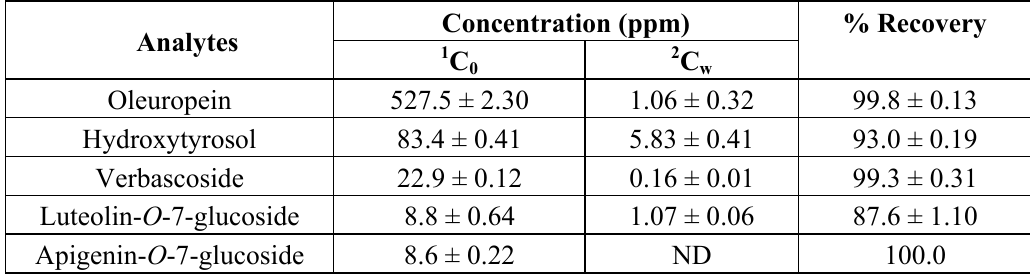
Table 1. Recoveries of the main polyphenolic compounds detected in the initial olive leaf extract and the water phase (V ) of single salting-out-assisted CPE in the presence of w SO (w/v). 1 C : the concentration of phenolic compounds present in the initial 35% Na 2 4 o olive leaf extract. The sample was diluted four times prior to HPLC analysis; 2 C concentration of phenolic compounds present in the aqueous phase after salting-out CPE; ND: not detected; ±standard deviation ( n = 3). Conditions: pH: 2.6; 4% Tween 80 (w/v);